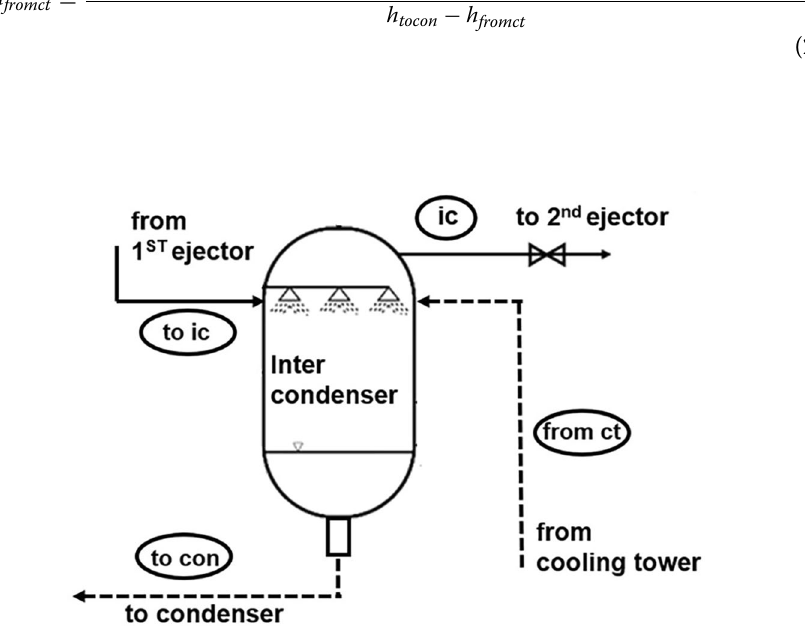
Fig. 9 The inter-condenser flow